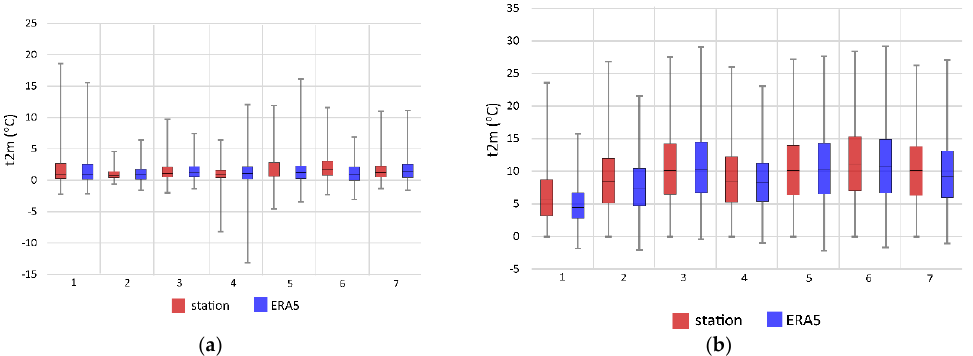
Figure 7. 2m air temperature at seven stations ( red ) and at the nearest grid points of ERA5 reanalysis ( blue ) for the periods of snow thaw ( a ) and summer rains ( b ). Boxes indicate the lower and upper quartile. Horizontal line in each box represents the median t2m air temperature. “Whiskers” extending from each box represent the minimum and maximum temperature recorded for each station.